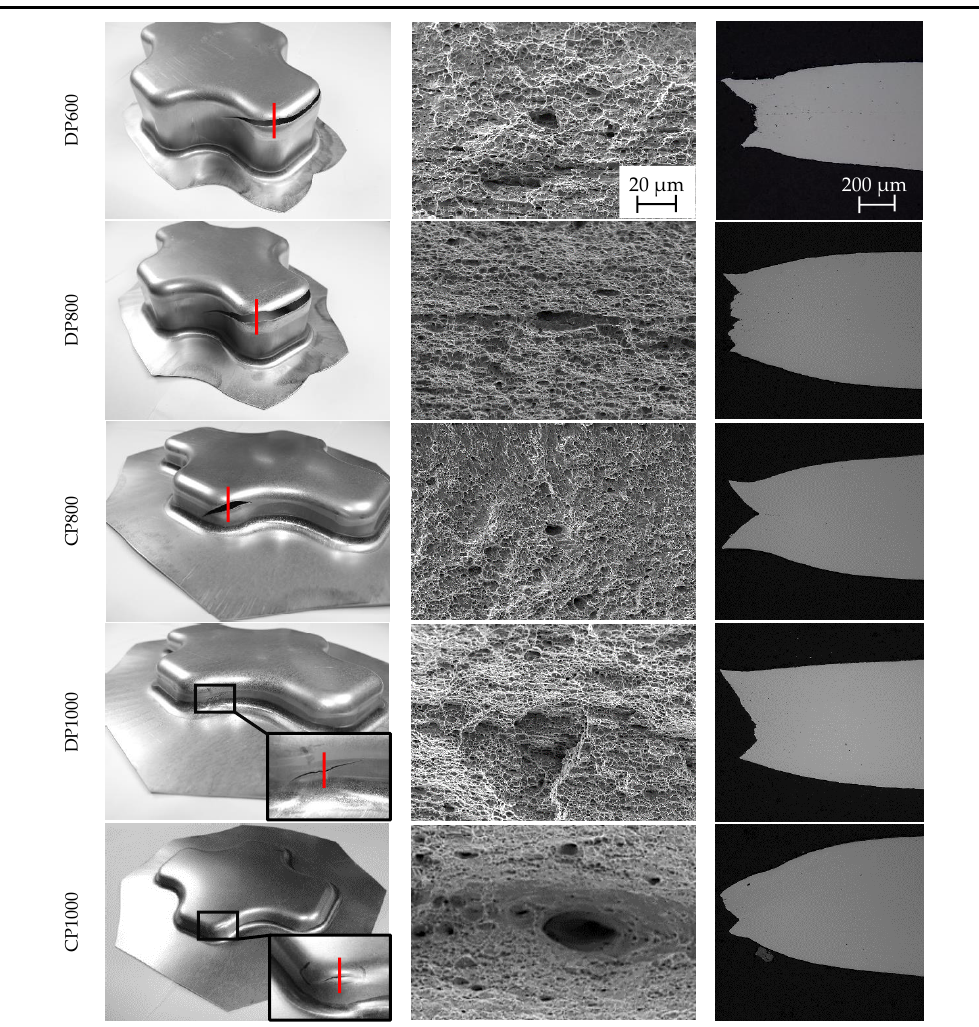
Table A10. Ductile fracture of cross-die samples.